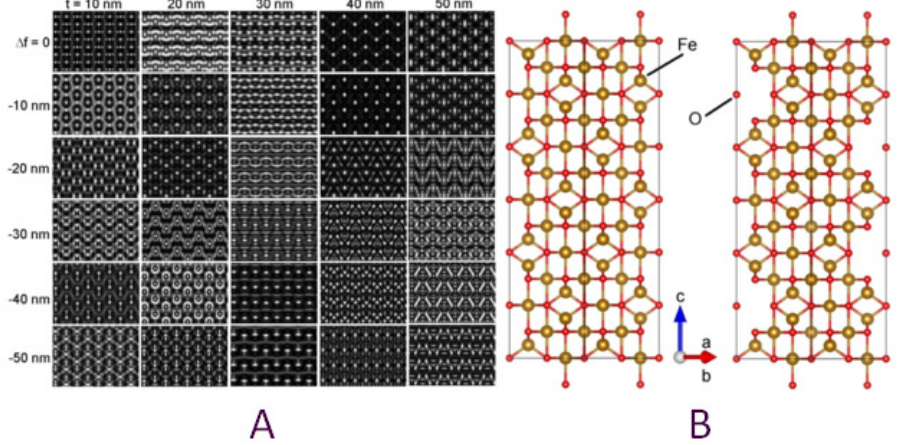
Figure 7. ( A ) Matrix of simulated HRTEM patterns based on the tetragonal unit cell of maghemite in B = [30–1] orientation. ( B ) Structural model of the tetragonal unit cell of maghemite (right-hand side) viewed along the [1–10] crystallographic direction revealing the vacant octahedral Fe positions with respect to the same structure with fully occupied atomic positions (magnetite).